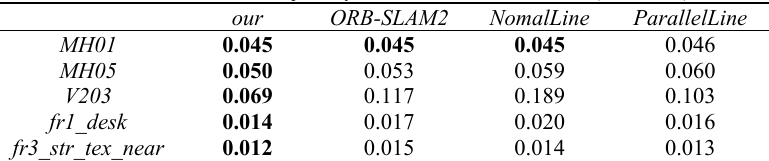
Table 3. The absolute trajectory error of the four methods (in meters).